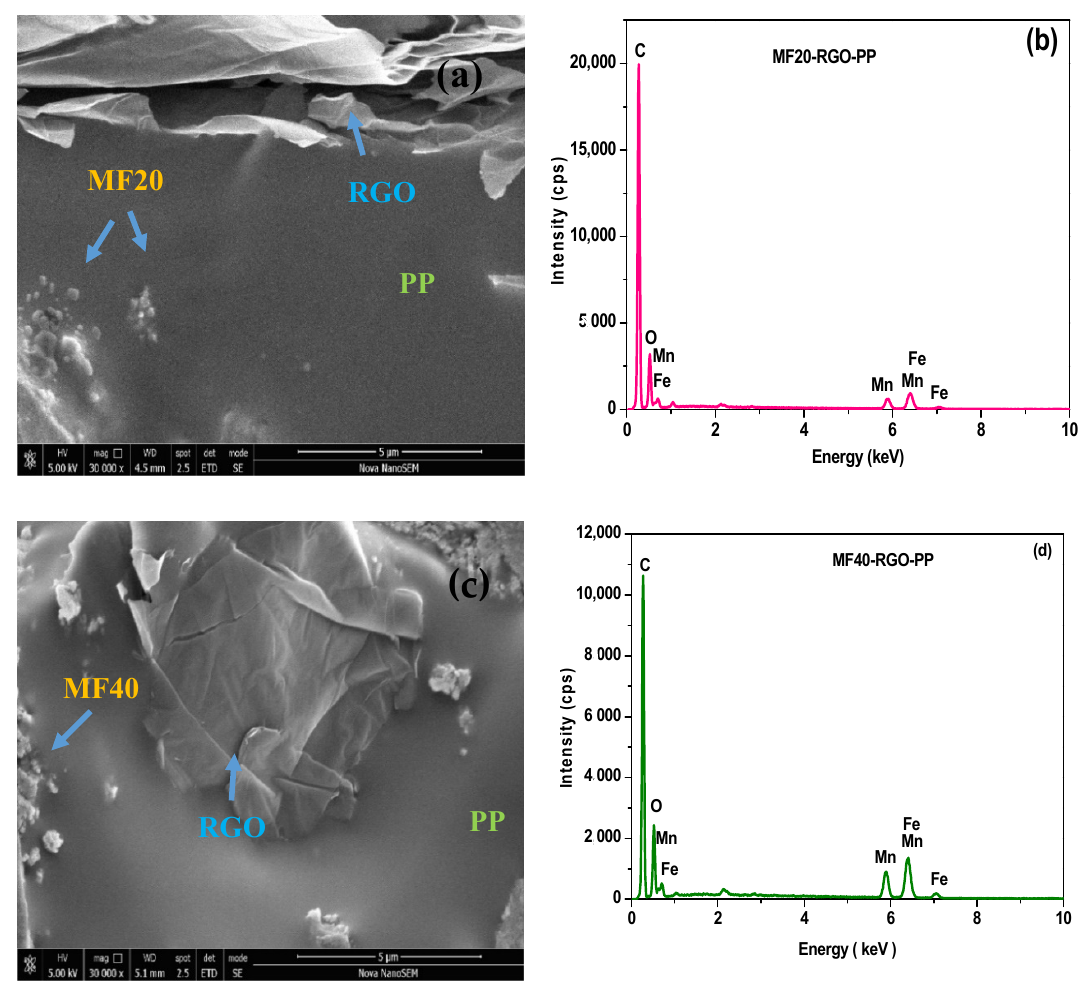
Figure 6. ( a ) FE-SEM image of cross-sections of MF20-RGO-PP, ( b ) EDX spectrum of MF20-RGO-PP, ( c ) FE-SEM image of cross-sections of MF40-RGO-PP and ( d ) EDX spectrum of MF40-RGO-PP.